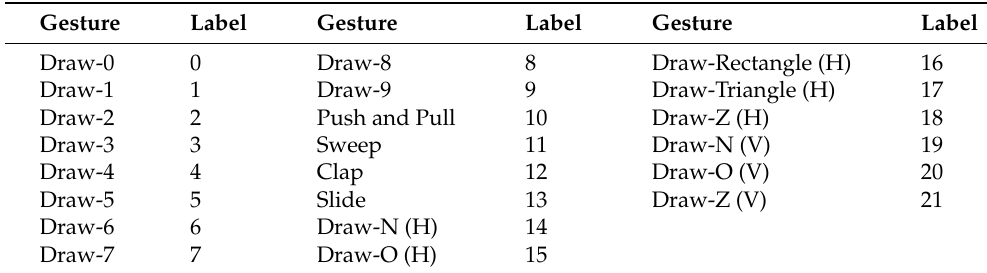
Table 2. The numerical labels corresponds to the 22 gestures, “H” represents horizontal and “V” represents vertical.